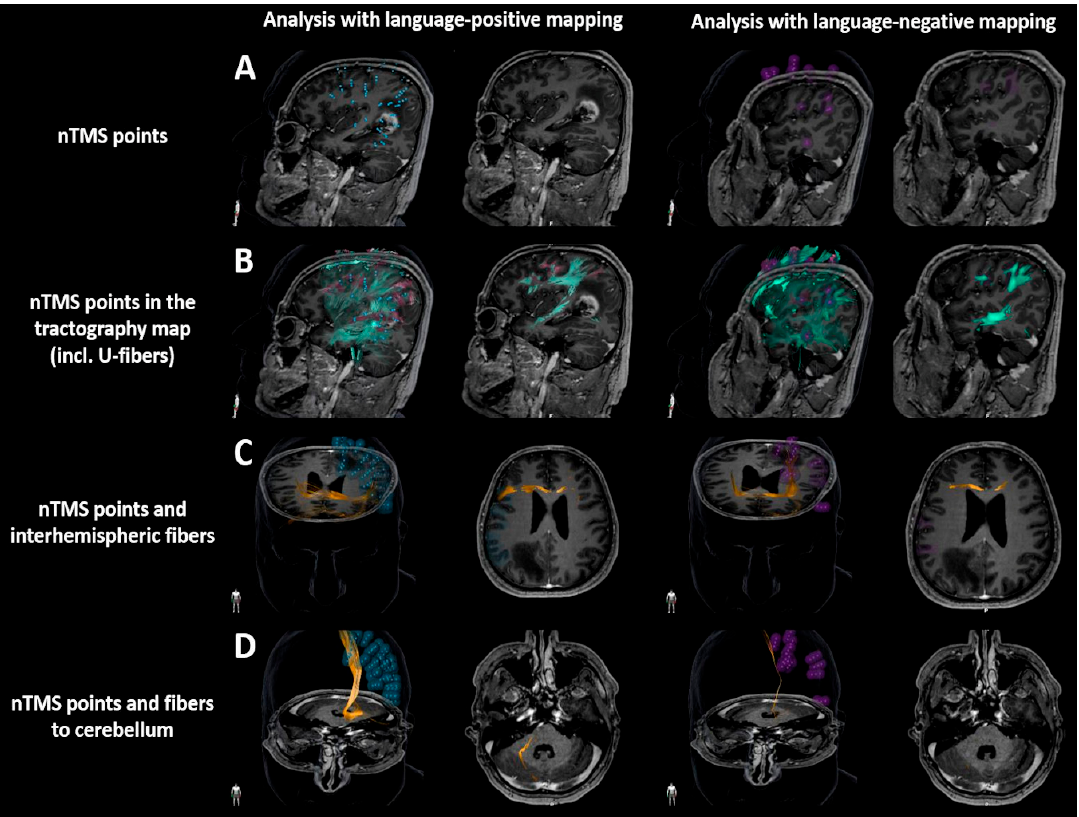
Figure 4. Analysis of subcortical fiber tracts. Tractography maps were generated based on language mapping data derived from navigated transcranial magnetic stimulation (nTMS), using the language-positive nTMS spots and language-negative nTMS spots as separate regions of interest (ROIs). Row ( A ) visualizes the language-positive nTMS points (blue) and language-negative nTMS points (purple) in an exemplary patient case with a left-hemispheric contrast-enhancing tumor with temporo-parietal location. Row ( B ) illustrates the complete picture of tractography (green fibers) with special emphasis on U-fibers (purple fibers). Row ( C ) depicts interhemispheric fiber courses (orange fibers) crossing the midline via the corpus callosum. Row ( D ) visualizes fibers projecting to the cerebellum (orange fibers).